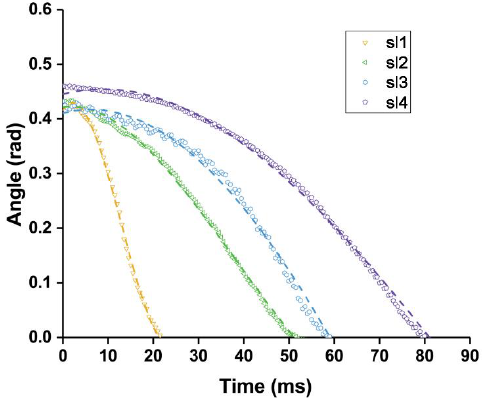
Figure 4. Angle changes with panel angle θs variation. When the angle between the two panels increases, the angles of motion are changed because the radius of the motion is decreased.